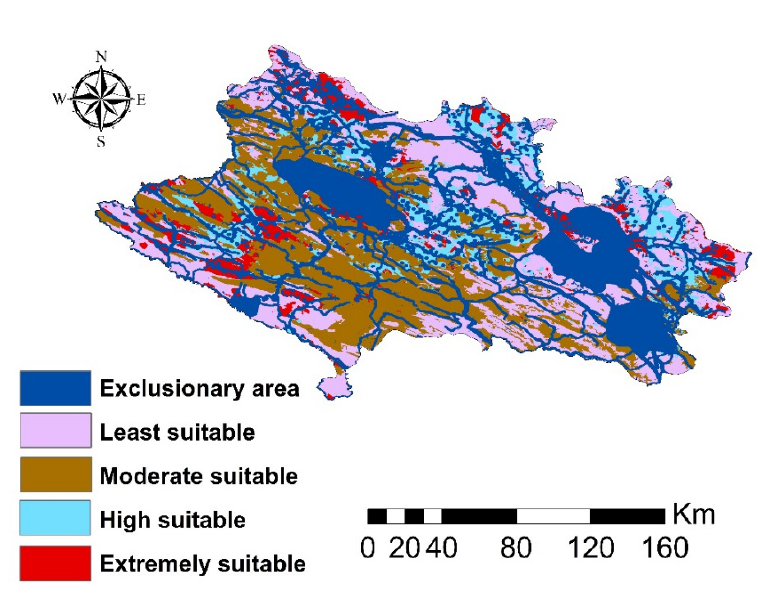
Figure 7 . Final map in fuzzy PROMETHEE method for Lorestan province